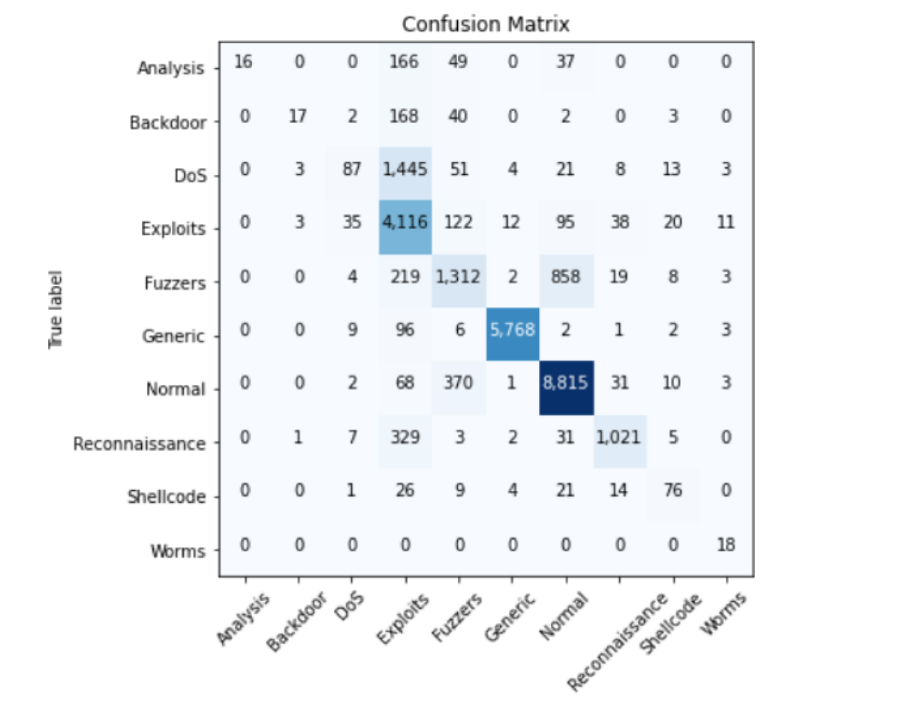
Figure 4. Correlation Matrix.